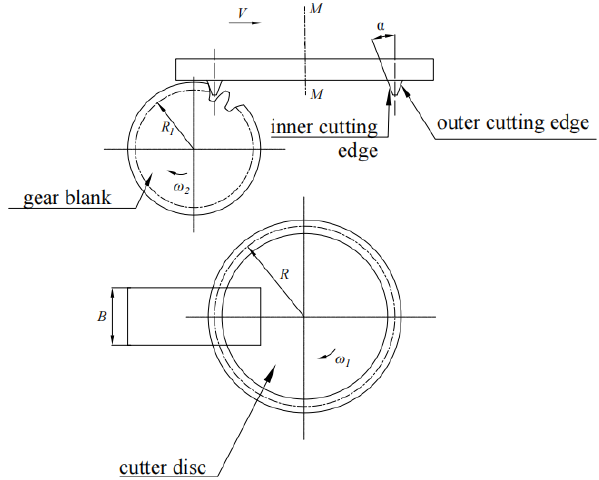
Figure 5. Processing principle of VH-CATT cylindrical gears.